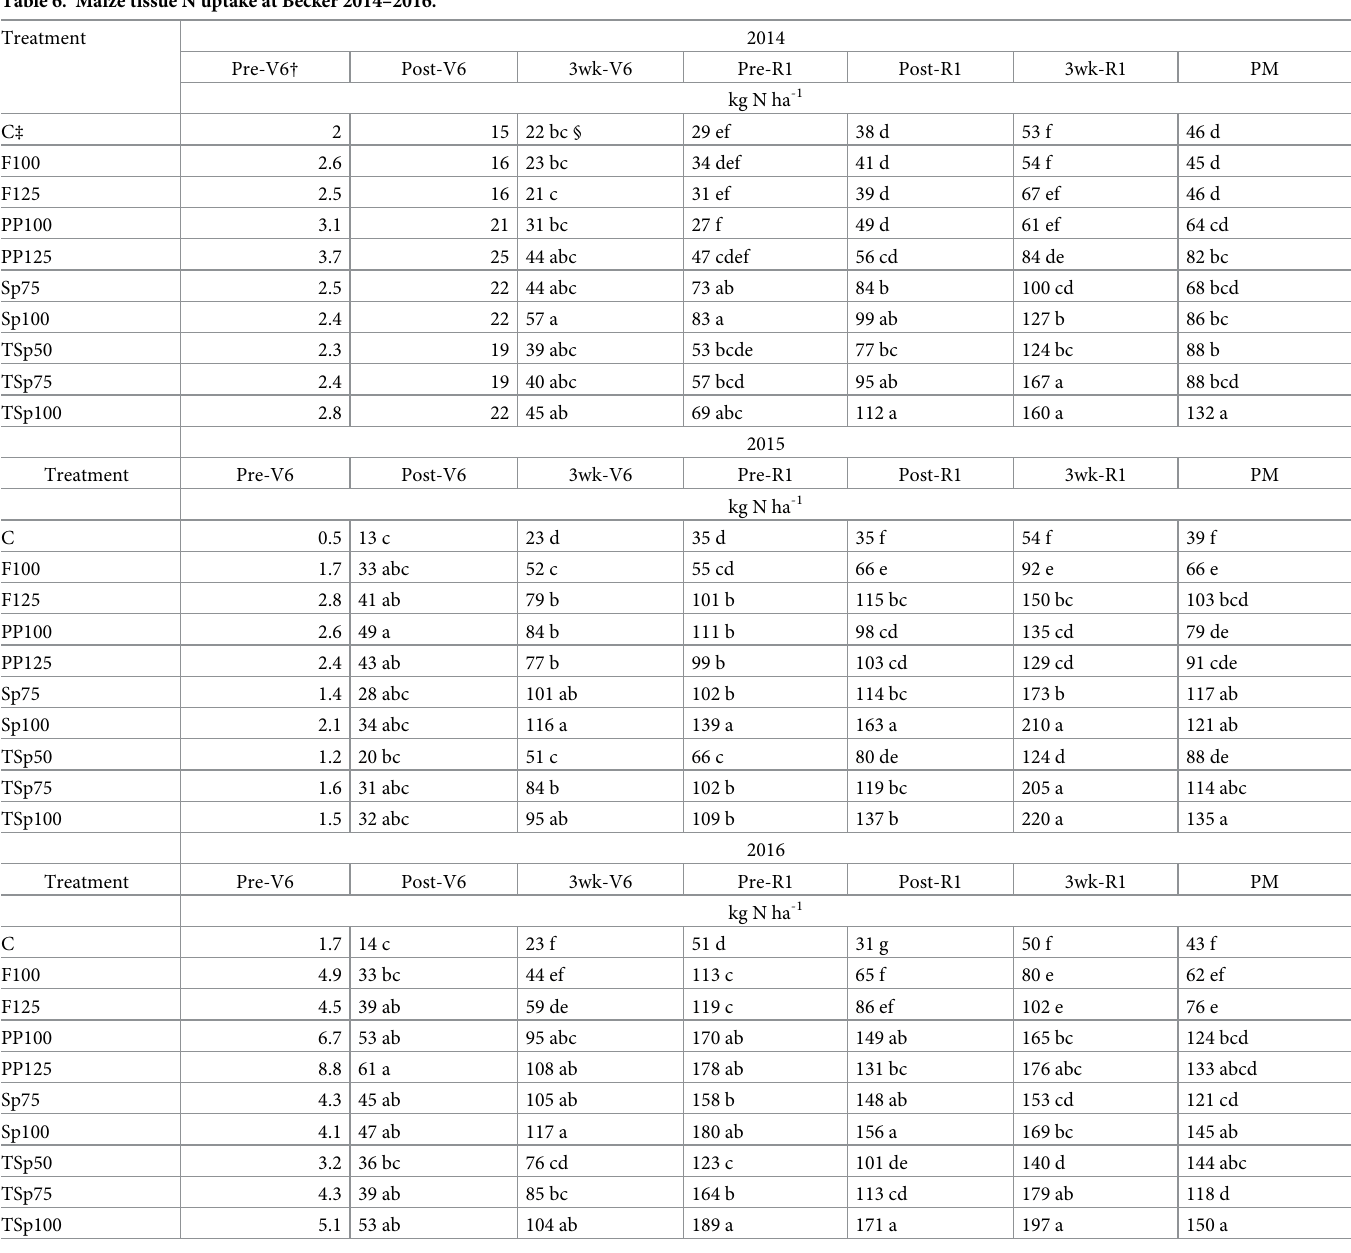
Table 6. Maize tissue N uptake at Becker 2014–2016.